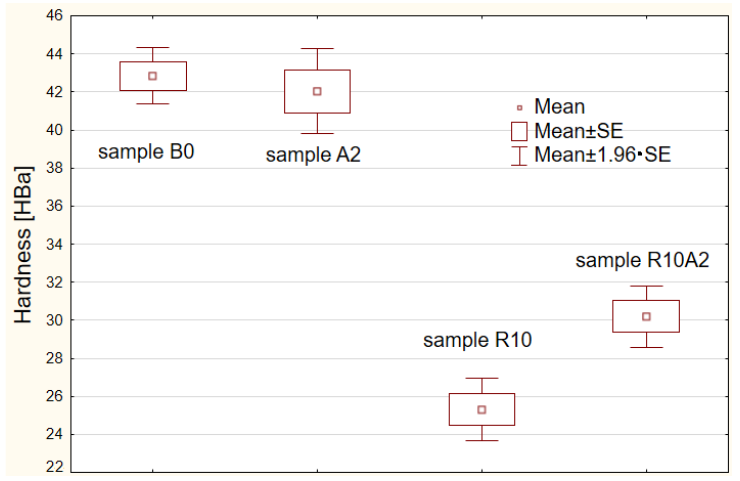
Figure 5. Multiple comparison chart for individual samples where: mean ± SE was mean ± standard error and mean ± 1.96 × SE was confidence interval for the mean. error and mean ± 1.96 × SE was confidence interval for the